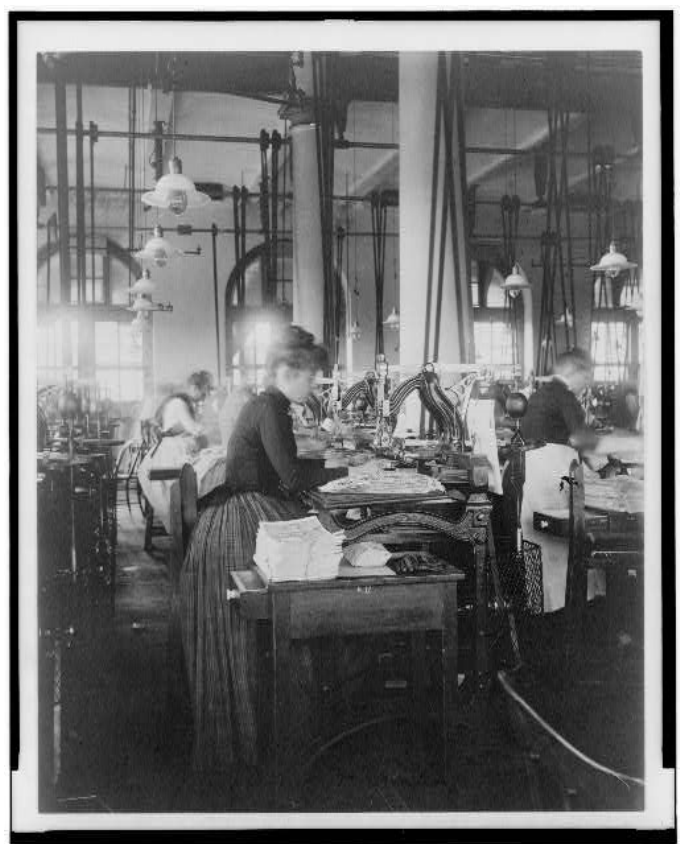
Figure 21. Frances Benjamin Johnston. 1890. Women operating machinery at the Bureau of Engraving and Printing. Library of Congress.